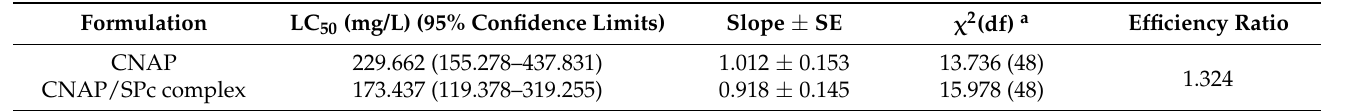
Table 4. Toxicity of CNAP and CNAP/SPc complex against adults of Orius sauteri at 24 h after the